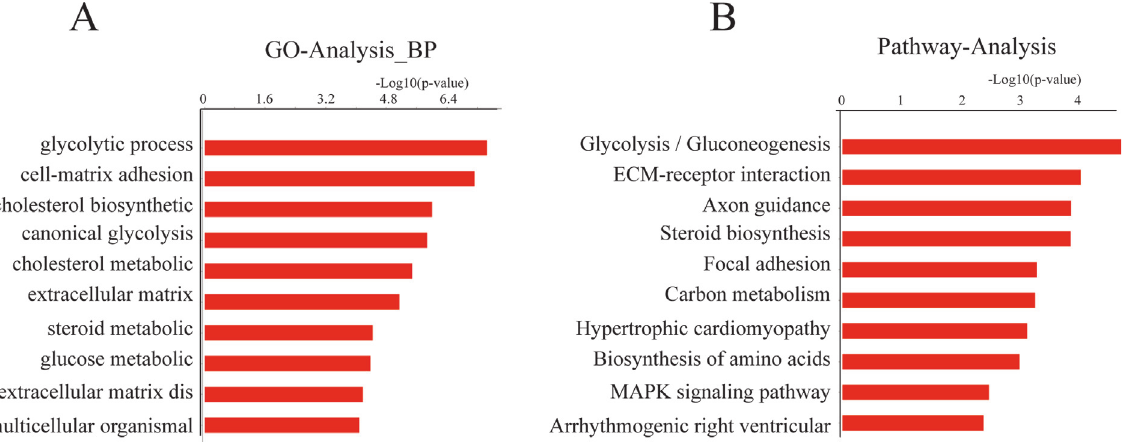
Figure 5 - GO category and KEGG pathway analysis of down-regulated genes in UPS22 silencing HeLa cells. (A) The significant GO categories for down-regulated genes using the threshold of P < 0.05 and FDR < 0.05 for the selection of significant GO categories. (B) The significant pathways of down-regulated genes using the threshold of P < 0.05 and FDR < 0.05 for the selection of significant KEGG pathways.